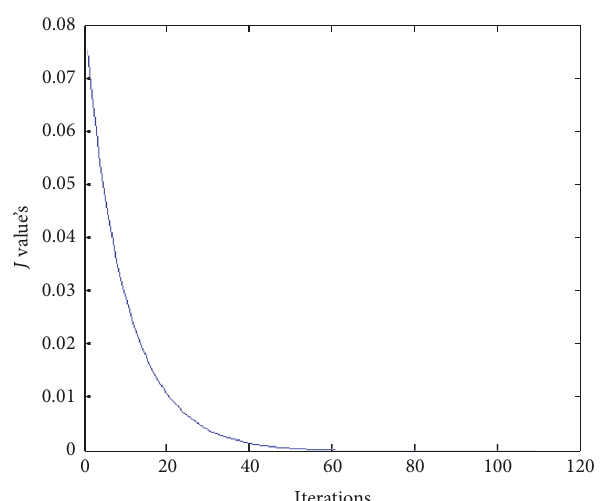
Figure 8: Initial temperature in err = 20% ‖𝜓 exact 0 ‖ 2 case. This figure shows that we cannot rebuild the true state.